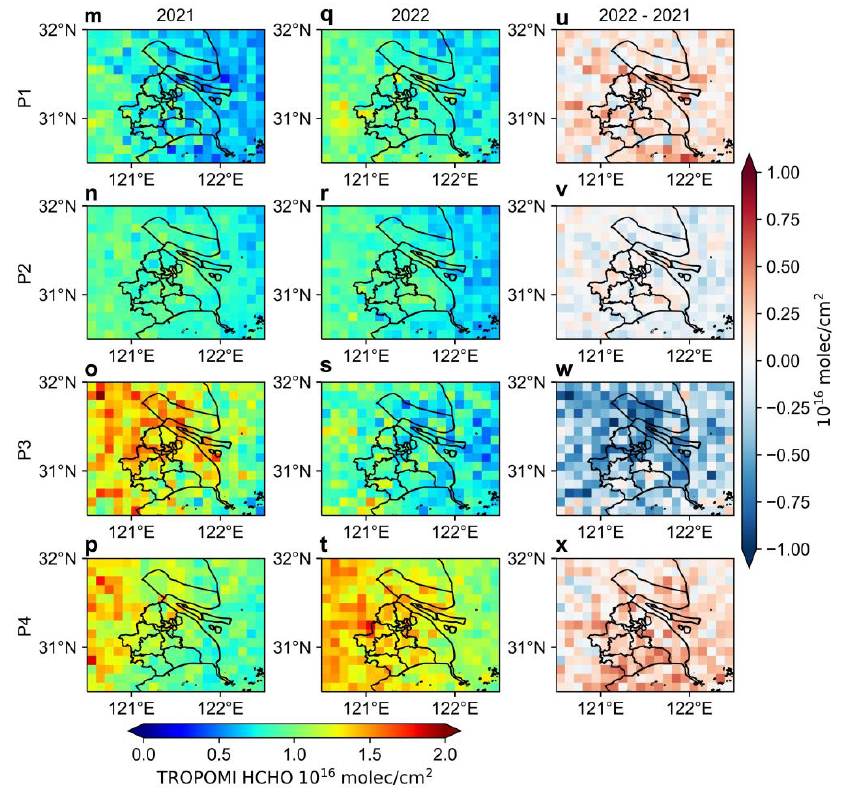
Figure 4. ( a – i ) Spatial distributions of TROPOMI tropospheric NO 2 VCDs in Shanghai from P1 to P4 in 2021 ( a – d ), 2022 ( e – h ) and the absolute differences between these two years ( i – l ); ( m – x ) is the same as ( a – i ) but for TROPOMI tropospheric HCHO VCDs.